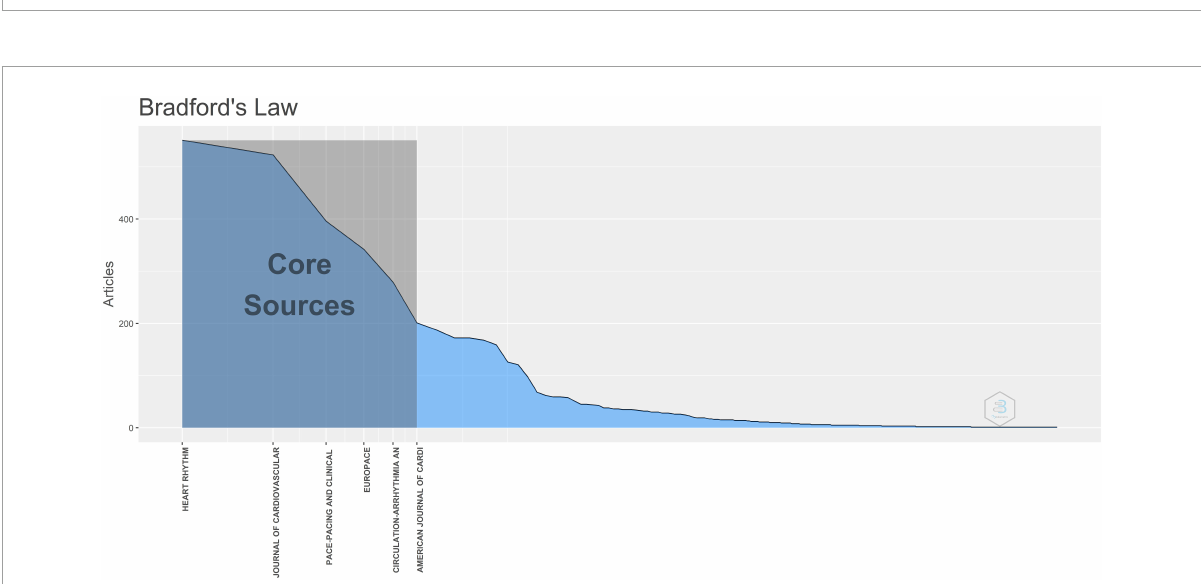
FIGURE4 Journal distribution of publications in ventricular arrhythmia research according to Bradford’s law.